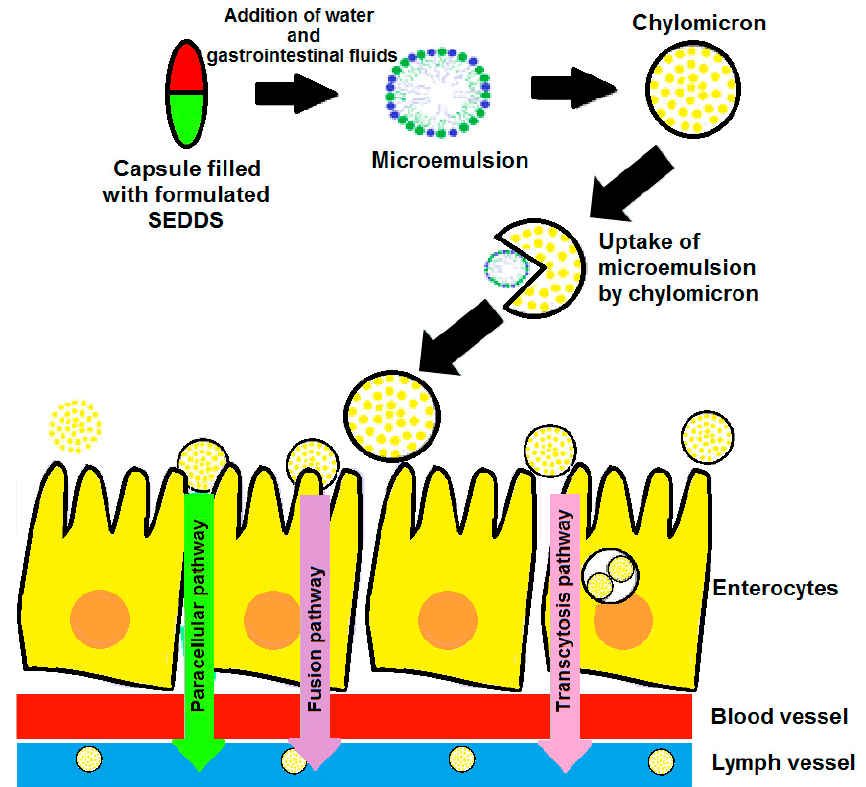
Figure 5. Schematic representation of di ff erent uptake pathways exhibited by oral SEDDSs.